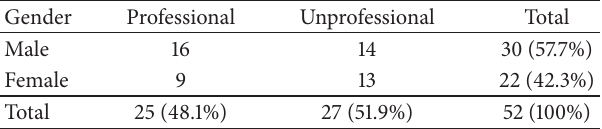
Table 1: Gender and vocation distribution of recruited subjects.